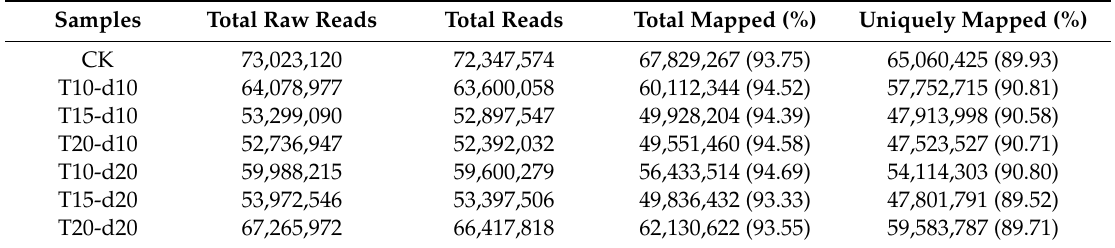
Table 1. Read number, based on RNA sequencing (RNA-Seq) data in